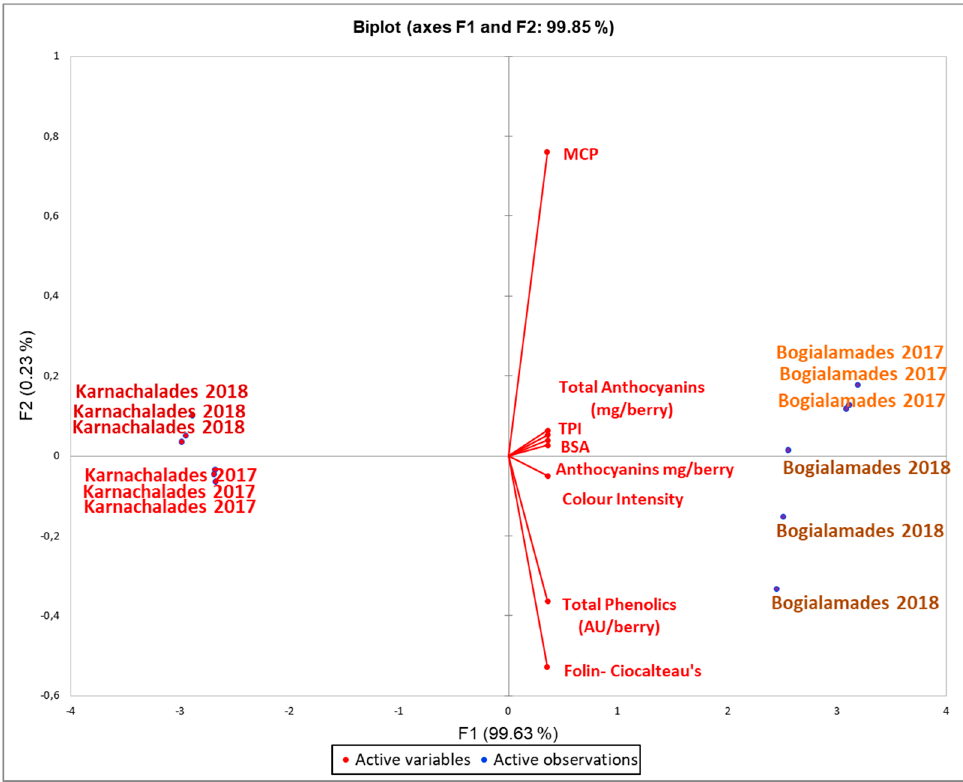
Figure 6. Biplot (PCA) for anthocyanins, total phenolics in grape berries and for color intensity, total anthocyanins, MCP, Folin–Ciocalteau’s, BSA and MCP method, TPI in the wines. Samples are grouped following the cultivar and the vintage. Left and bottom axes of the PCA plot are PCA scores of the samples (dots). Top and right axes of the PCA plot indicate how strongly each characteristic (vector) influence the principal components. PC1 and PC2 explaining, respectively, 99.86% of the variation of the data. Variables in plot were colored according to the variety.